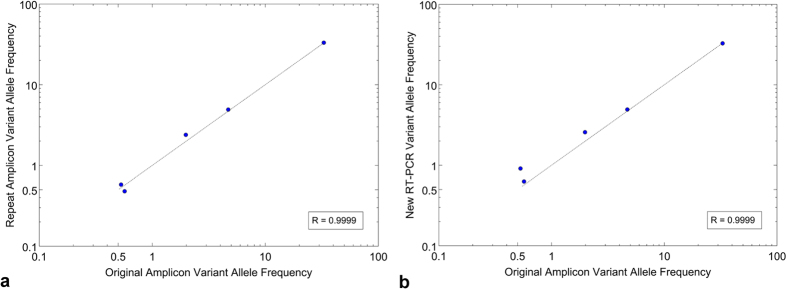
Mutation reproducibility demonstrated in independent experimental replicates.The reproducibility of quantitative mutation detection was determined with a series of independent experimental replicates. The effects of (a) PCR amplification and (b) reverse transcription were evaluated. An inclusive 0.5% fractional cutoff was used and all mutations found in one of the sample replicates were considered simultaneously. The correlation coefficient for each comparison was calculated and the best-fit slope was plotted.